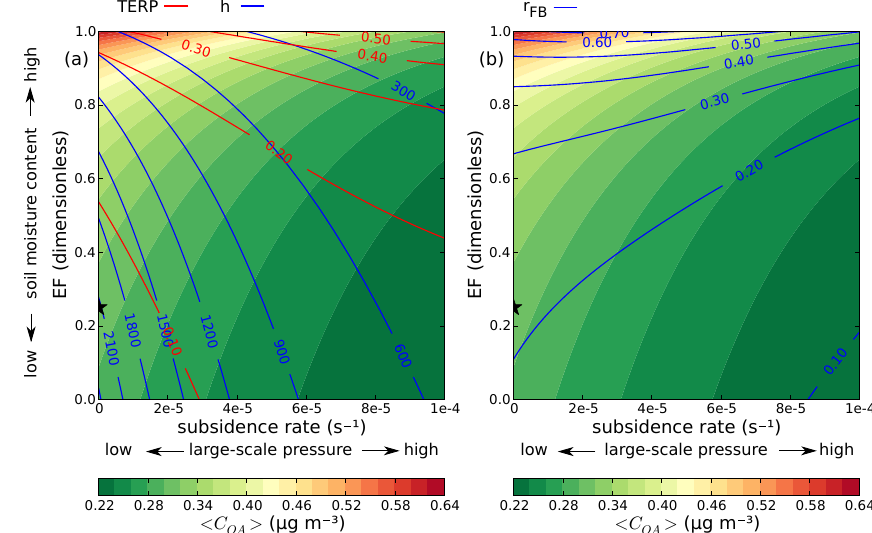
Fig. 11. (a) Sensitivity of organic aerosol concentration ( C OA ), BL height ( h ) and TERP concentration at 18:50LT to subsidence and evaporative fraction (EF). Shades indicate C OA (µgm − 3 ), the blue contours h (m), and the red contours TERP concentration (µgm − 3 ). (b) Sensitivity of C OA and the the OA chemistry background ratio ( r FB ) at 18:50LT to subsidence and evaporative fraction (EF). Shades indicate C OA (µgm − 3 ) and the blue contours r FB (dimensionless). The asterisk indicates the conditions for the case